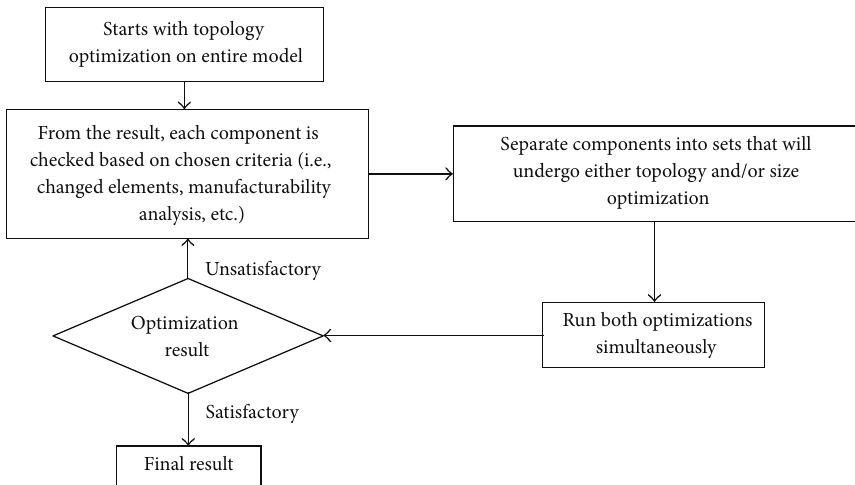
Figure 8: Combination of size and topology optimization strategy.